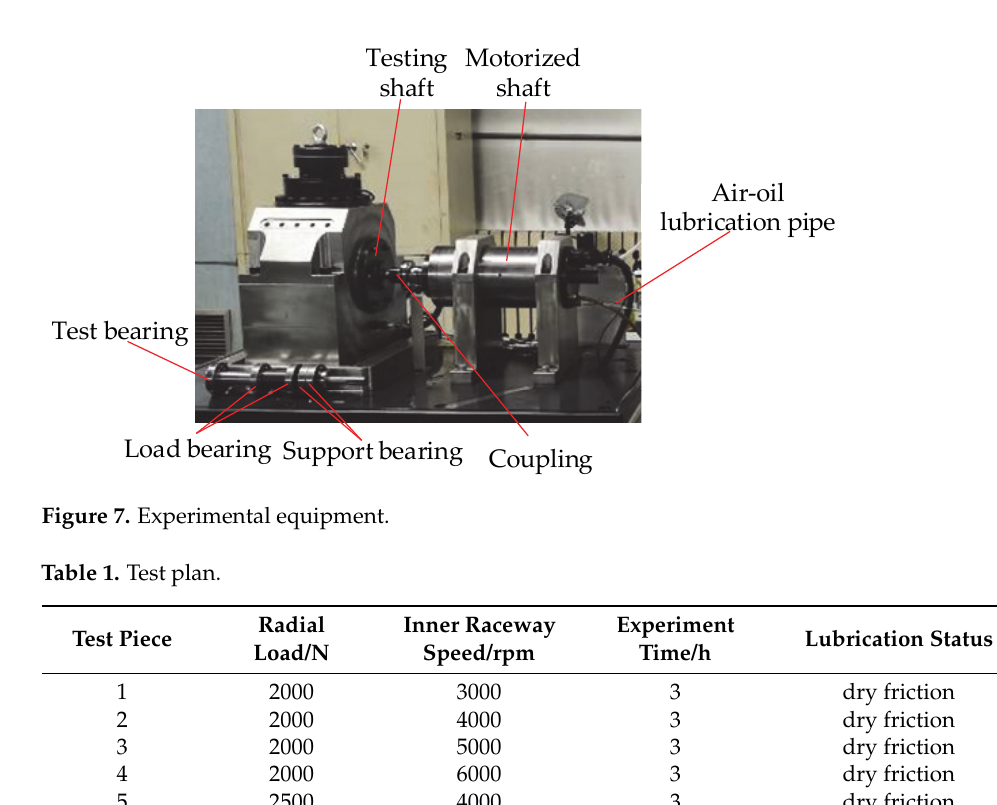
Table 2. Parameters for numerical solution of contact forces for rotational speed variations.